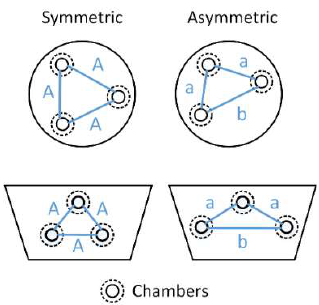
Figure 1. Cross-sectional views of the models and distances between chambers.